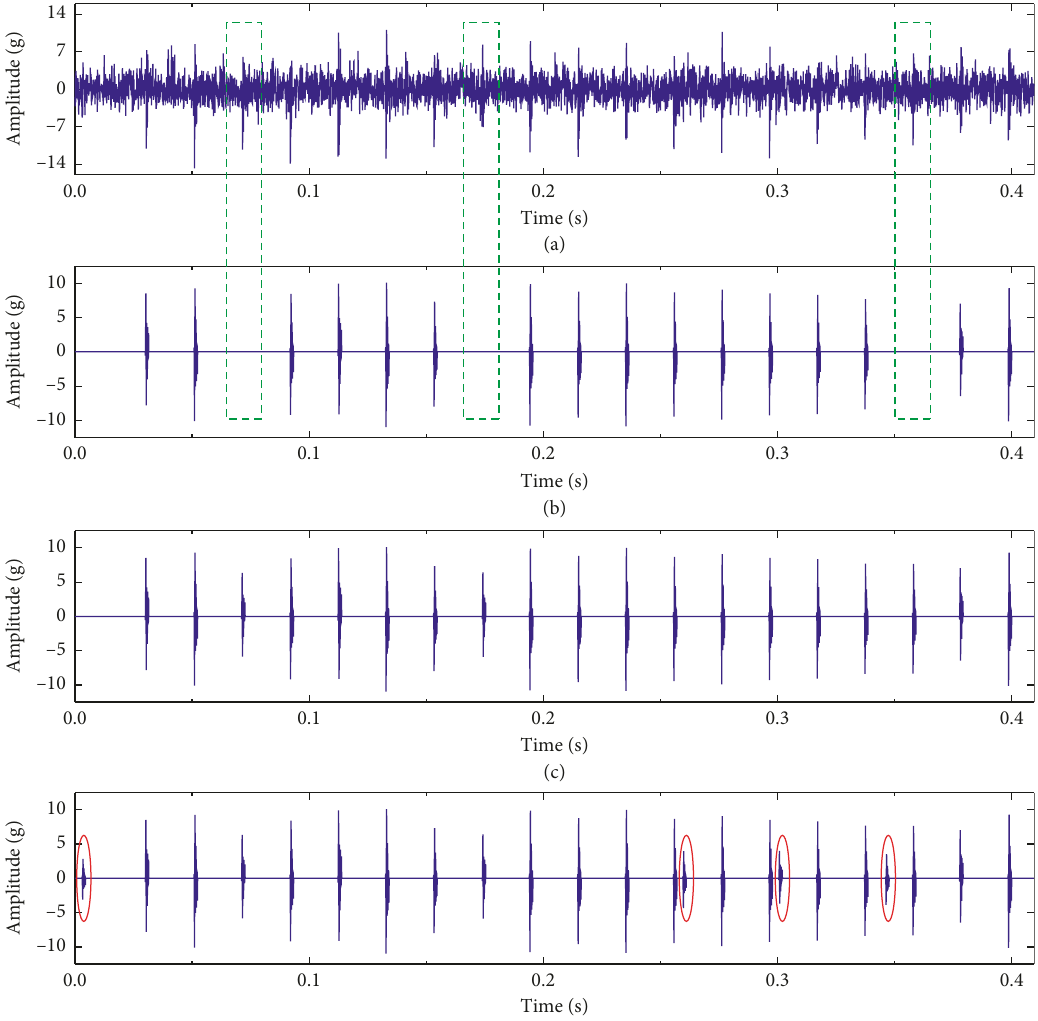
Figure 2: Separation of fault impulsive components with different numbers of iterations: (a) the waveform of the simulation signal with a � 16; (c) T � 19; (d) T � single fault; (b) T 0 0 0